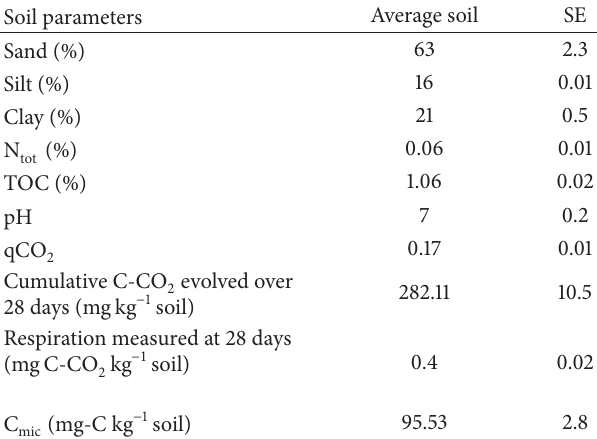
Table 1: Chemical and biochemical parameters of control soil, samples were collected at (0–30 cm). Data were calculated on averge of six field